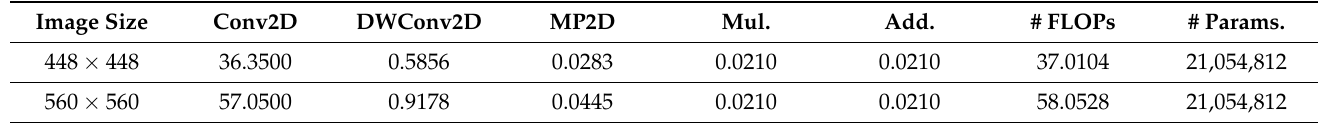
Table 2. The complexity analysis for the proposed architecture calculating the number of floating point operations in billions (B) for the convolution2D (Conv2D) layer, depth-wise separable convolution2D (DWConv2D), maxpooling2D (MP2D), multiplications, and additions. The total number of floating point operations (FLOPs) in billions and the total number of parameters (Params.) in full precision are also shown. The image size of 448 × 448 and 560 × 560 are the image sizes for the models trained on PASCAL VOC and MS-COCO,